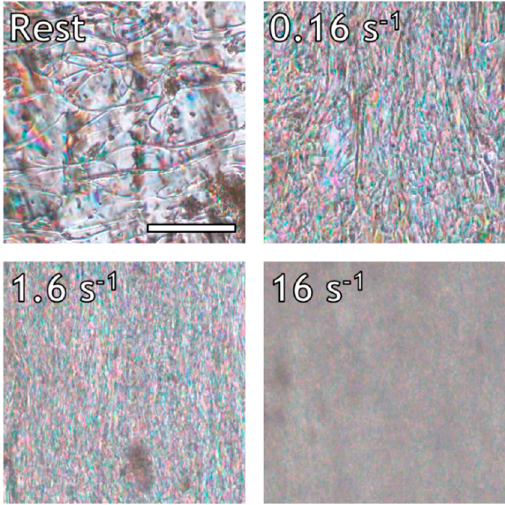
Figure 3. Equilibrium polydomain textures of the LCP under different shear rates at 200 ◦ C. The total strain was greater than 200 for each sheared sample. Flow direction is vertical, scale bar marks 100 µ m and applies to all